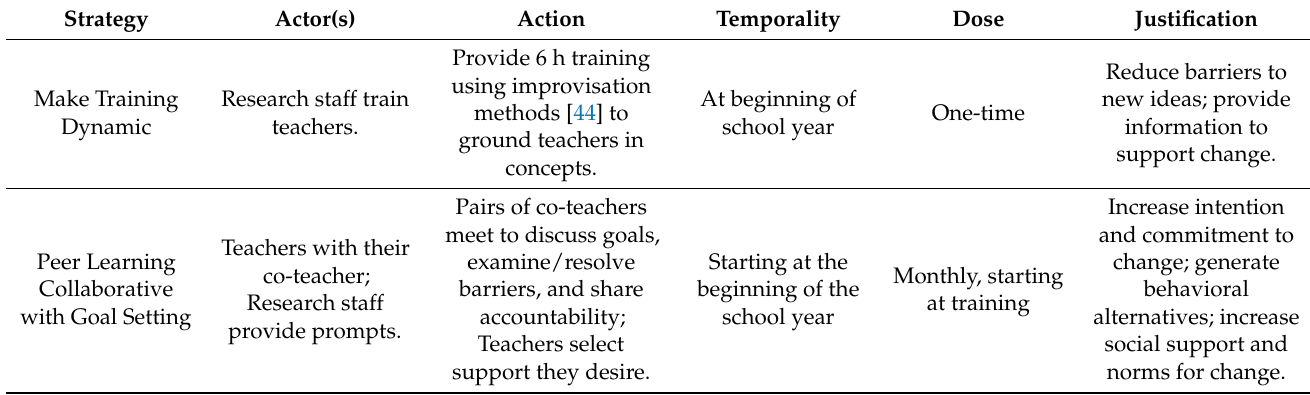
Table 1. Specification of multi-faceted de-implementation